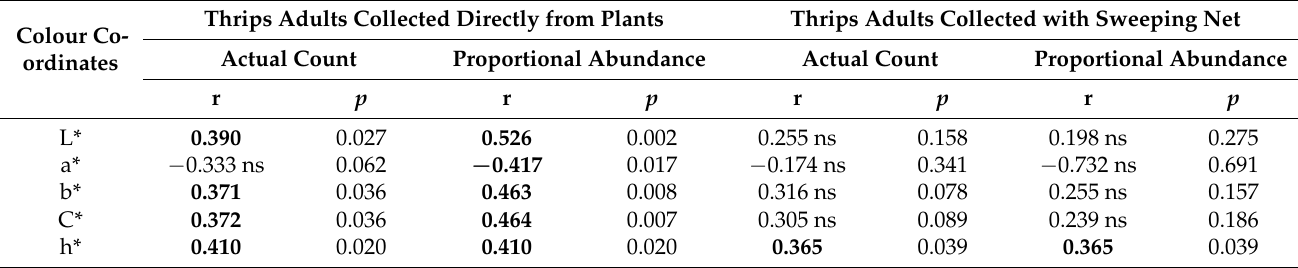
Table 6. Pearson’s correlation between colorimetric characteristics of onion leaves and actual count and proportional abundance of adults Thrips tabaci in 2016 (n =